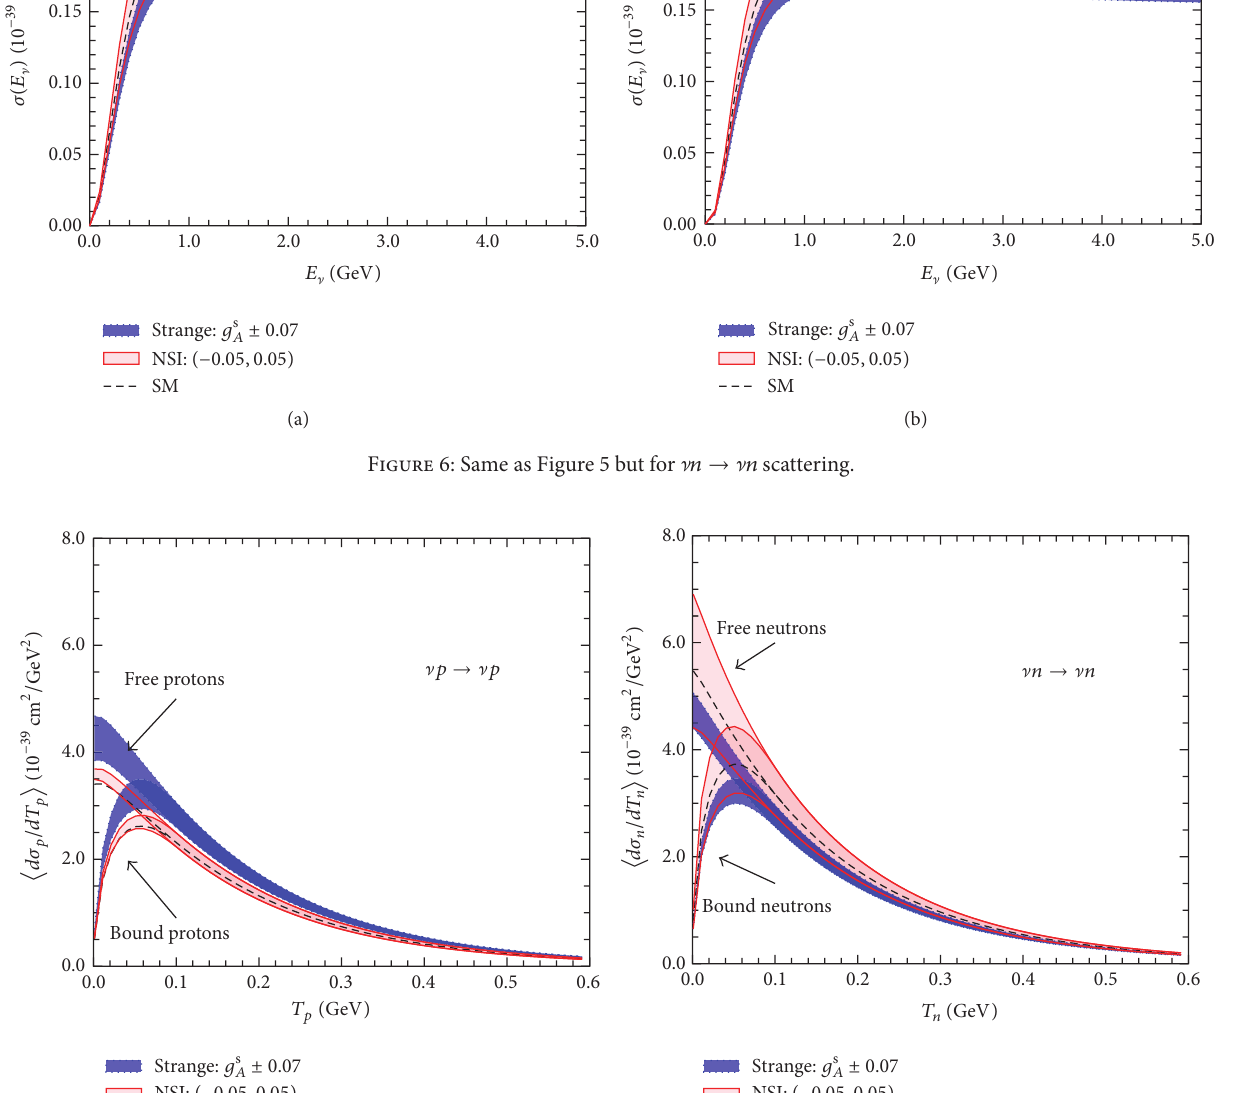
the number of POT in the data [46] and 𝑎(𝑇 N ) denoting